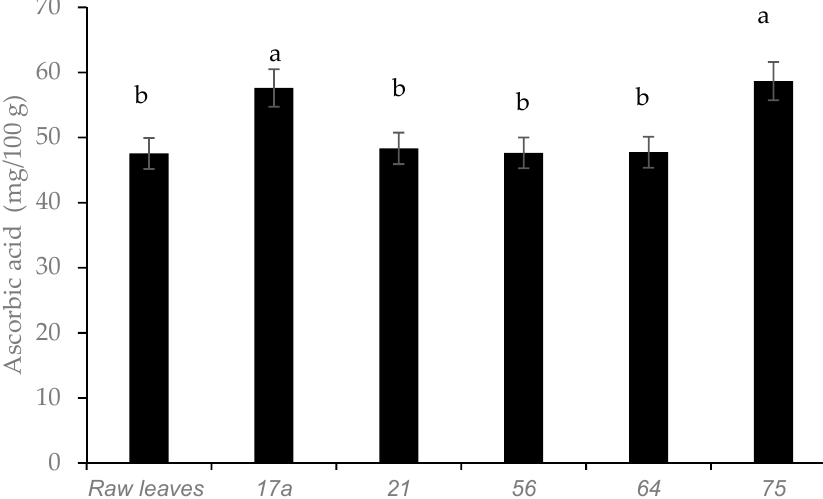
Figure 4. Influence of lactic acid fermentation with different LAB strains on ascorbic acid content in African nightshade ( Solanum retroflexum ) leaves. Each value represents the mean value of five replicate samples. Means followed by the same letter are not significantly different ( p < 0.05).